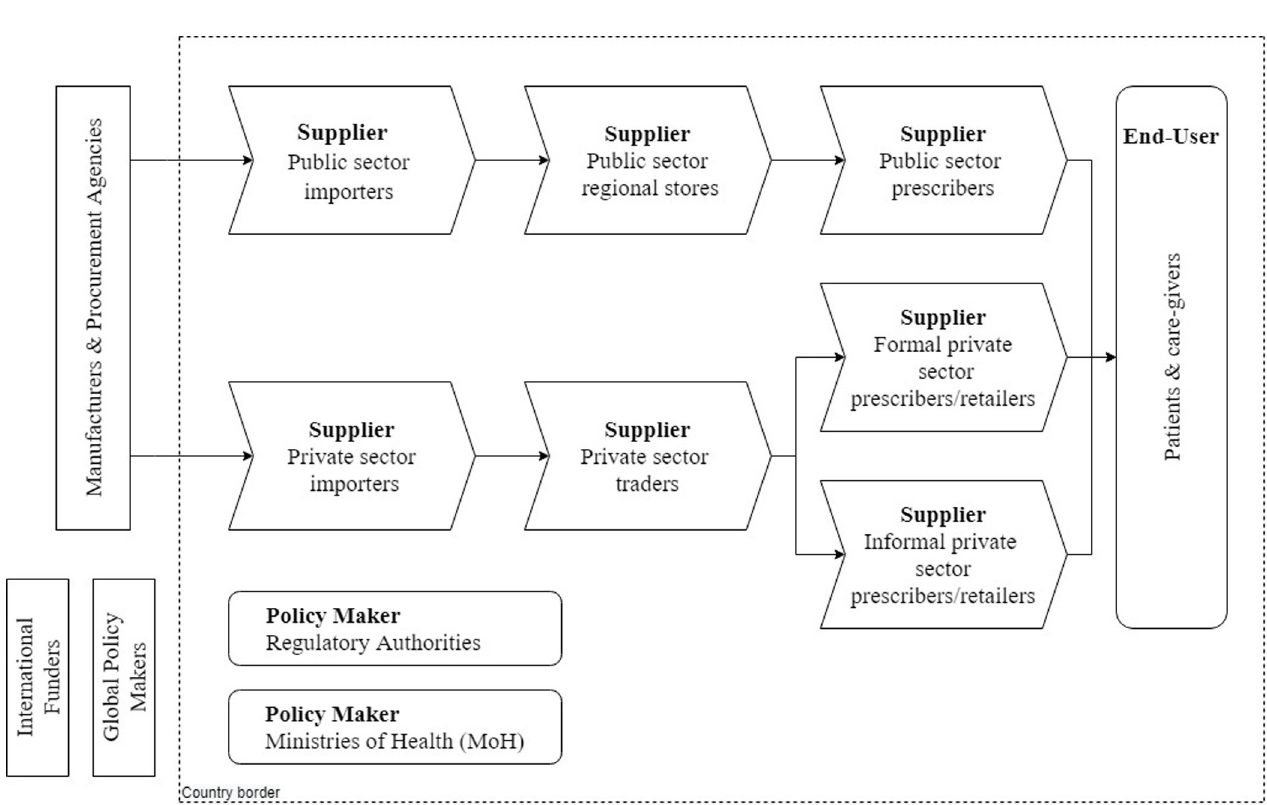
Fig 1. Key actor groups in the innovation system of antimalarial